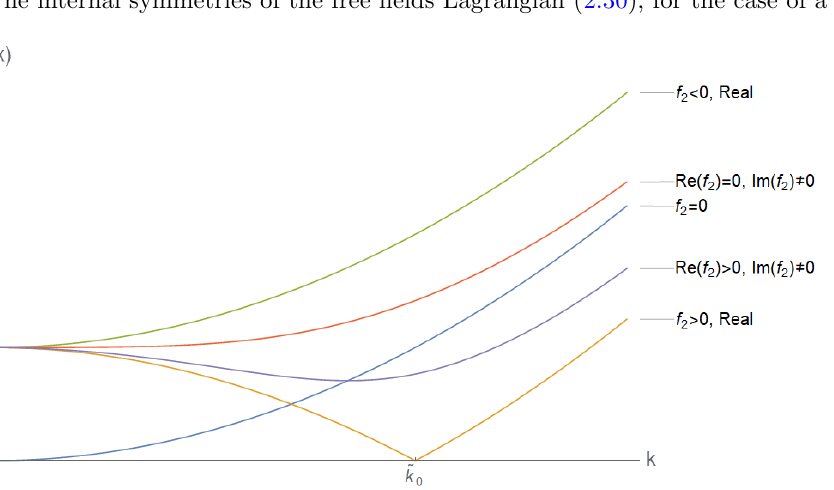
Figure 1 . The free particle dispersion